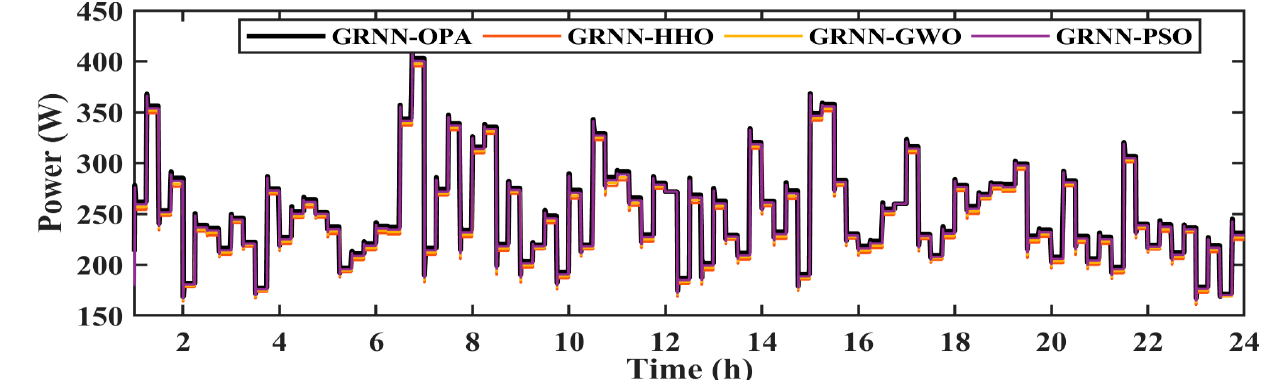
Figure 16. Comparison of power tracked in case 3.